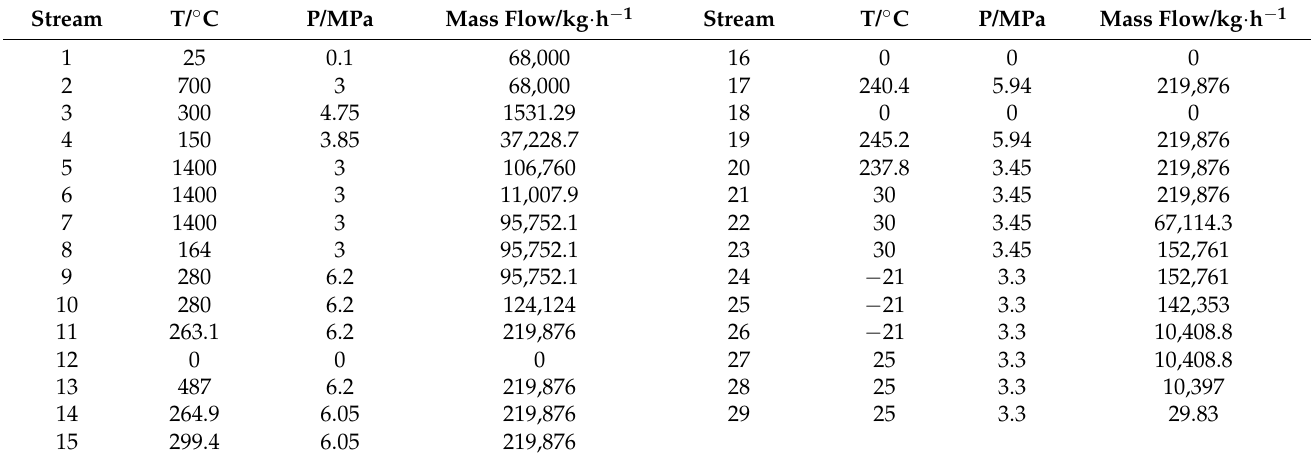
Table A2. Simulate Stream Results.